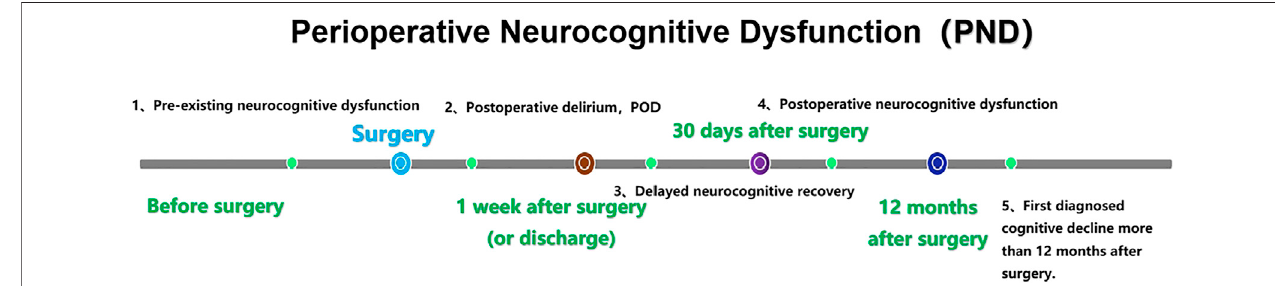
FIGURE1| NomenclatureofPND.PNDisdividedinto fi vecategoriesbytimeperiod,includingpreoperativeneurocognitivedysfunction(preoperative,measurable, objective impairment of cognitive function), POD (occurred within 1 week after surgery or before discharge and met the DSM-5 diagnostic criteria for delirium), delayed neurocognitive recovery (cognitive decline within 0 – 30 days after surgery), postoperative neurocognitive disfunction (pNCD or POCD, mild and severe cognitive decline existed from 30 days to 12 months after surgery) and fi rst diagnosed cognitive decline more than 12 months after surgery. Gut microbiota dysbiosis and intestinal barrier dysfunction.